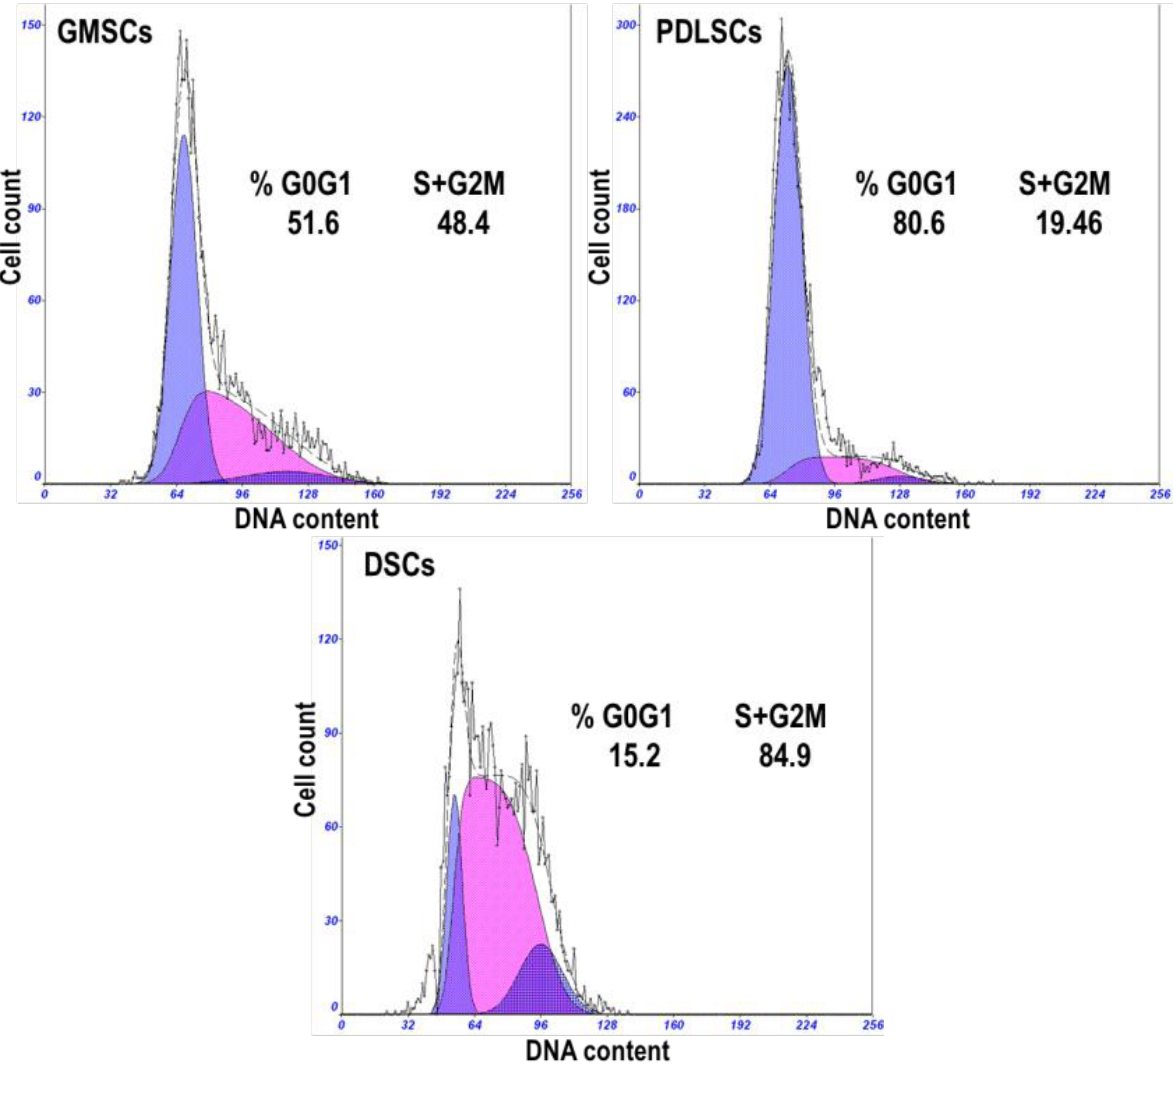
Figure 2. Representative cell cycle distribution graphs of gingival MSCs (GMSCs), periodontal ligament stem cells (PDLSCs) and dermal stem cells (DSCs) (P3). The percentages of cells residing in the G0/G1 phase, S and G2/M phases are shown in the